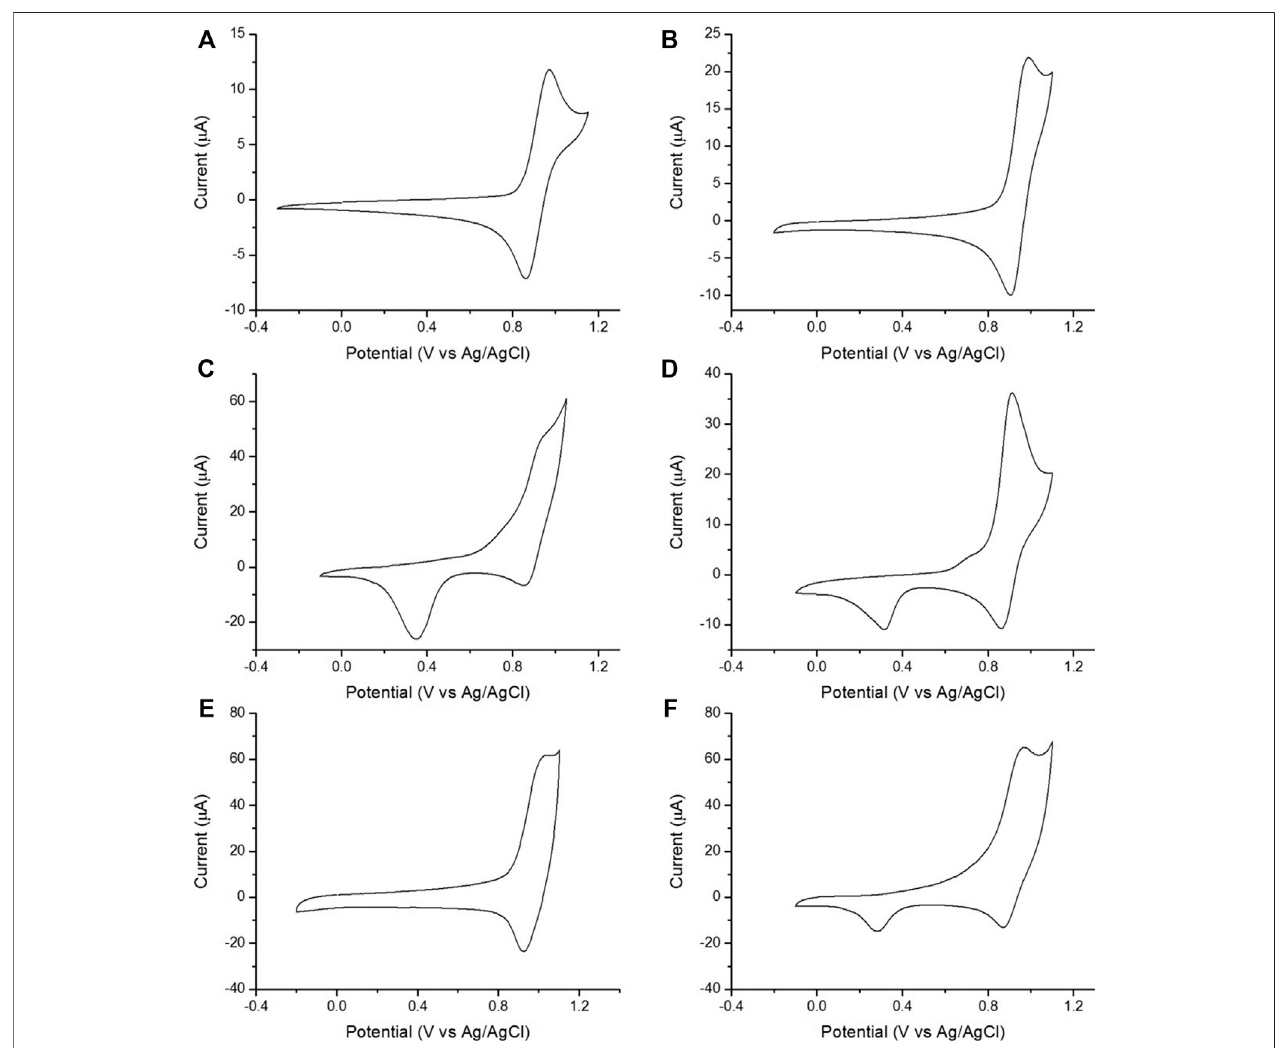
FIGURE 2 | Representative CVs of 1 mM [Ru(bpy) 3 ] 2+ in 0.1 M PBS (scan rate 0.1 V/s). (A) Kanichi. (B) DS-CNT. (C) DS-Au. (D) DS-GNP. (E) DS-GPH. (F) DS-GPH-GNP.